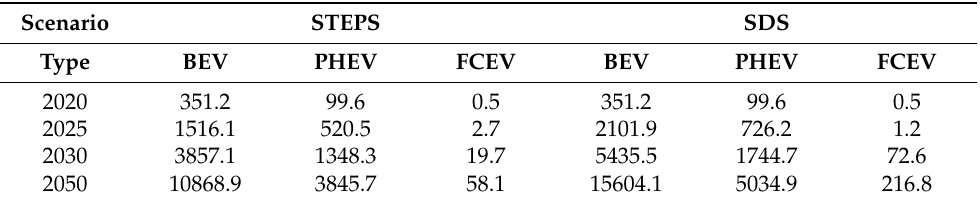
Table 4. Electric vehicle stock projection for 2020–2050 under different scenarios (Unit:1 × 10 4 ) (Data Source: [34]).